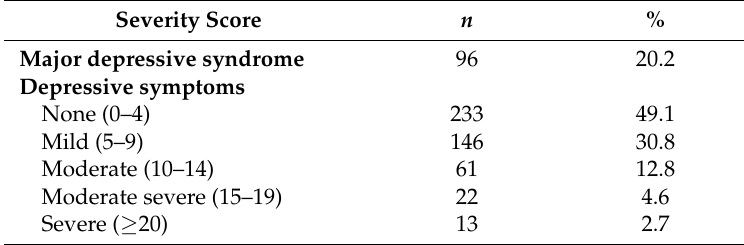
Table 3. Severity score of depression among patients receiving ART ( n = 482).